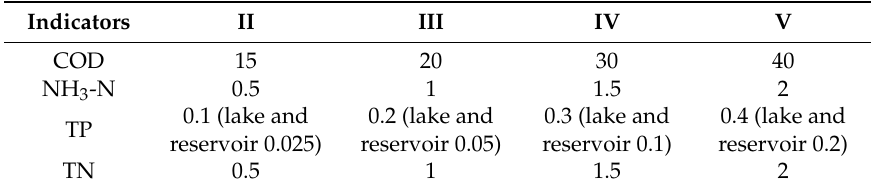
Table 2. The surface water environmental quality standard of China [35] (units: